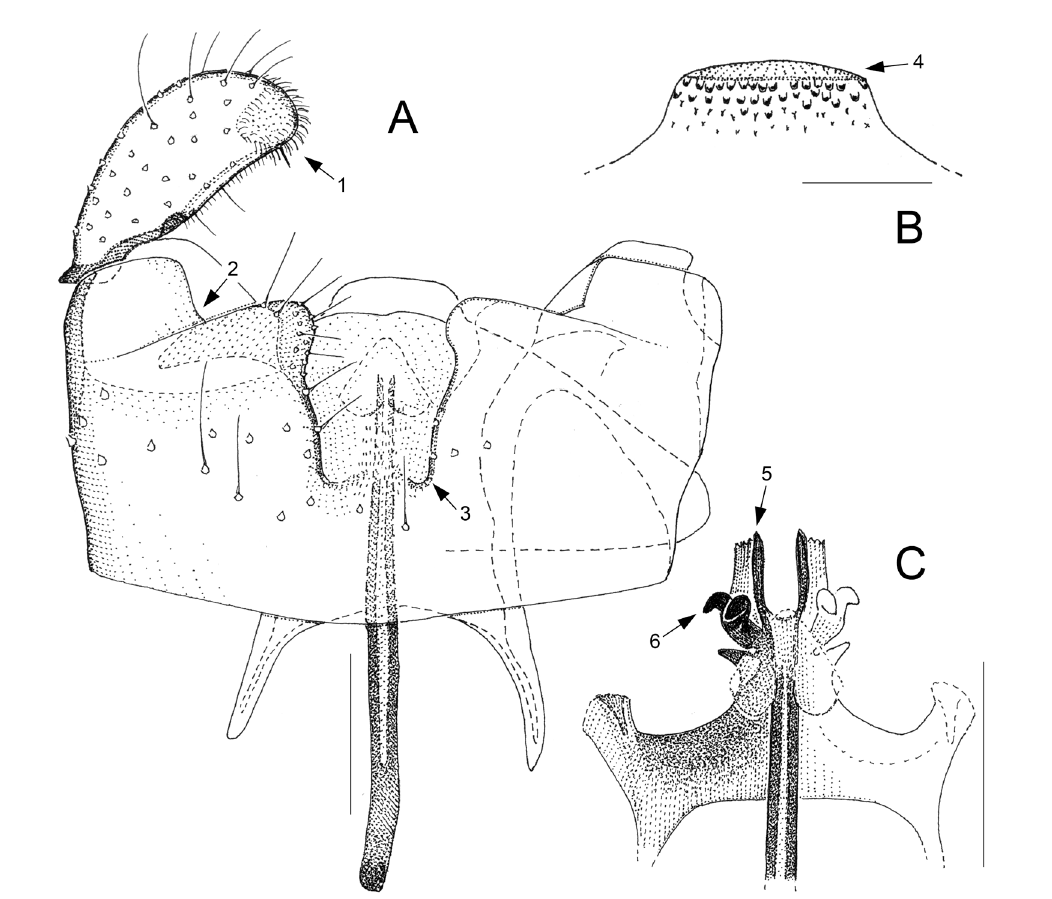
Fig. 14. Glemparon rotoiti sp. nov., holotype, ♂ (NZAC, no. CEC1425). A. Genitalia, ventral. B. Apex of ninth tergite, ventral. C. Apex of ejaculatory apodeme and tegmen, ventral. Scale bars: A, C = 0.05 mm; B = 0.025 mm. Numbered arrows indicate diagnostic characters (see